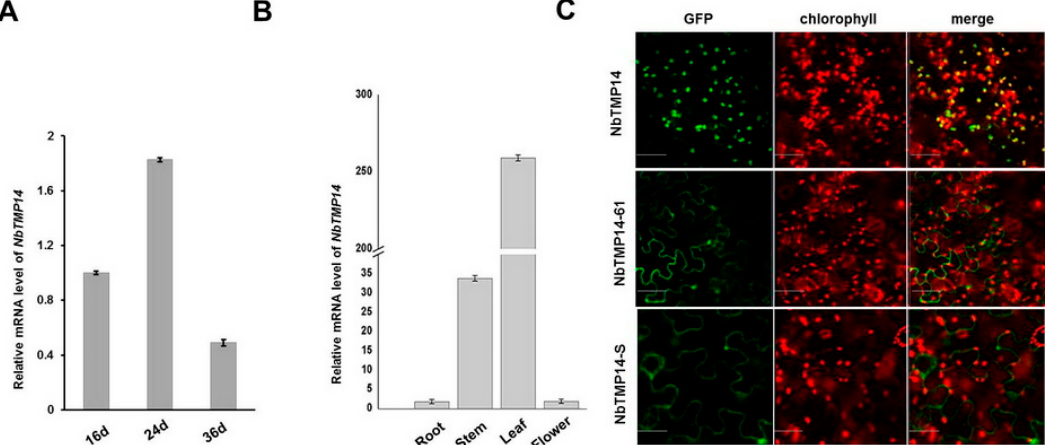
Figure 2. RT-qPCR assay of NbTMP14 gene expression and subcellular localization of NbTMP14 in N. benthamiana . ( A ) NbTMP14 relative expression levels in different stages of wild-type N. benthamiana . Bars represent the mean ± standard error. ( B ) NbTMP14 relative expression levels in different organs of wild-type N. benthamiana . ( C ) Fluorescence of NbTMP14, NbTMP14-S (signal peptide), and NbTMP14–61 (mature protein) in leaf epidermal cells of N.benthamiana ; chlorophyll autofluorescence was used as a marker. Scale bars represent 100 µ